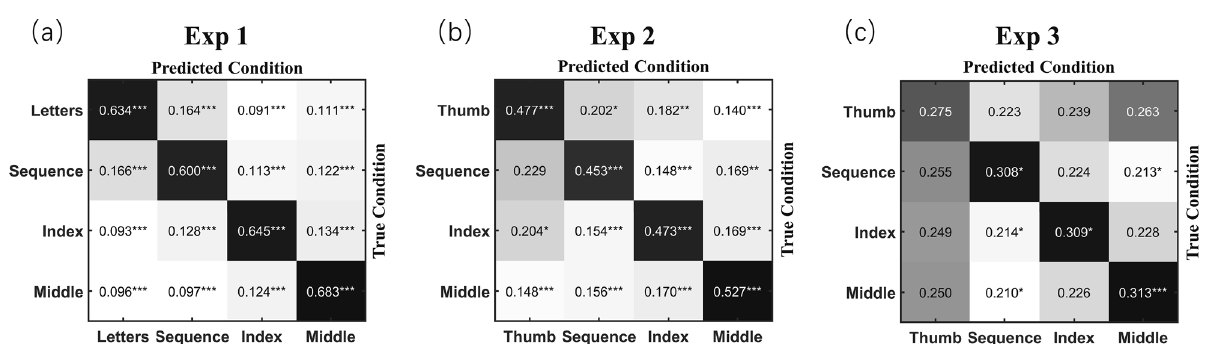
Figure 5. Tapping amplitude of finger trajectories varying as a function of attentional focus. Each panel indicates results with respect to the amplitude for each tapping finger normalized to the reference condition. X-axis labels indicate four attentional focus conditions, with the first label indicating the reference condition whose amplitude had been normalized to 0. The error bar indicates one SEM.